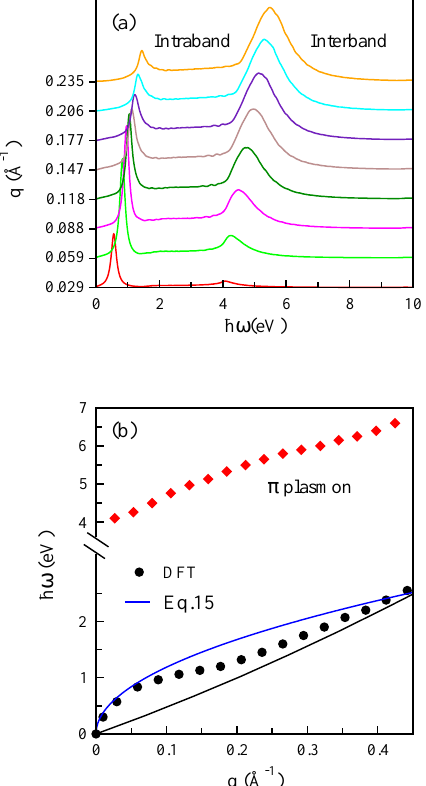
Figure 3. ( a ) The electron-energy loss (EEL) function for different momentum transfers and ( b ) plasmon dispersions of electron-doped graphene along the Γ − M direction. In this case, the Fermi level is shifted upward by 0.8 eV above the Dirac cone, and this corresponds to a doping level of 7.4 × 10 13 cm − 2 . The plasmon mode based on the semiclassical approach given by Equation (15) is plotted. The boundary of the electron-hole continuum is indicated with a black